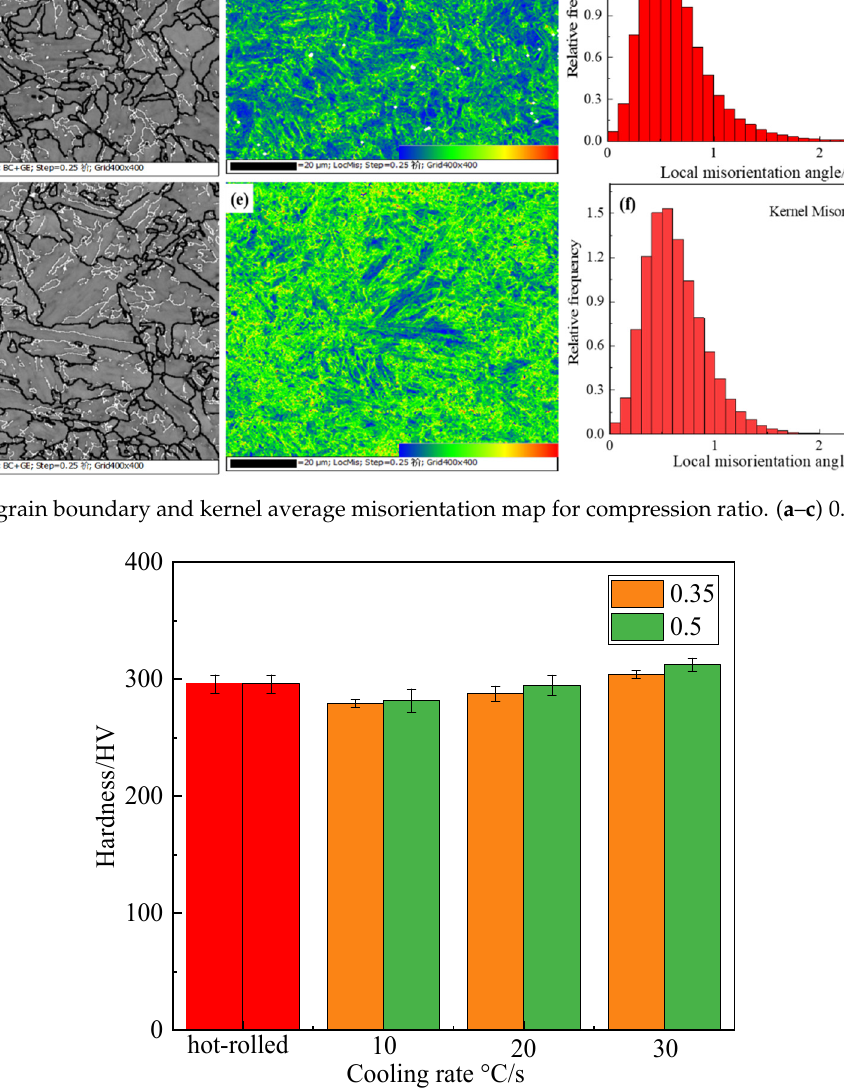
Figure 6. The microhardness of the pipeline steel with different cooling rate and compression de- formation.